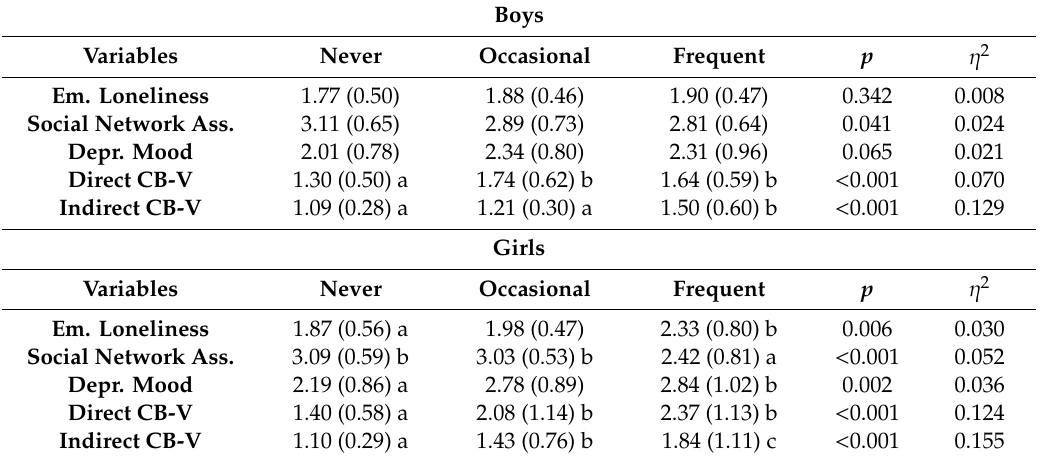
Table 4. Means (standard deviation) for loneliness, depressive mood and cyberbullying victimization in adolescent boys and girls with di ff erent cyber-aggression victimization experiences. Boys Variables Never Occasional Frequent p η 2 Em. Loneliness 1.77 (0.50) 1.88 (0.46) 0.008 Social Network Ass. 3.11 (0.65) Depr. Mood